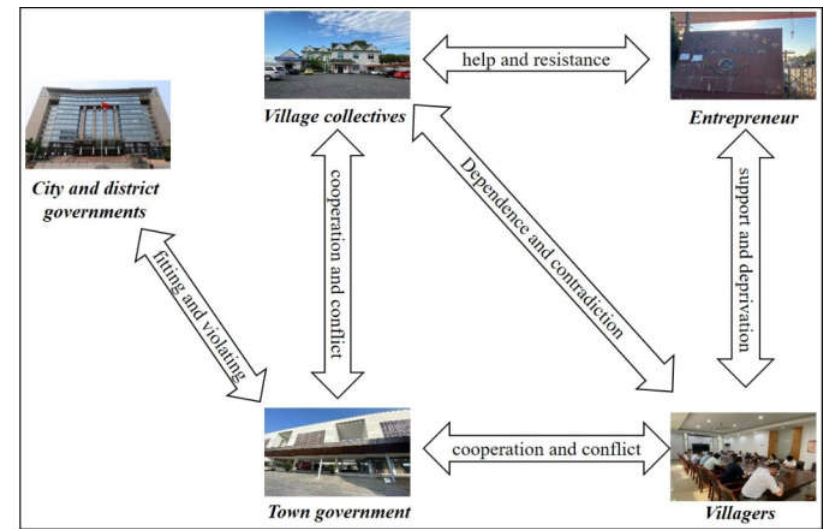
Figure 2. Relationships among